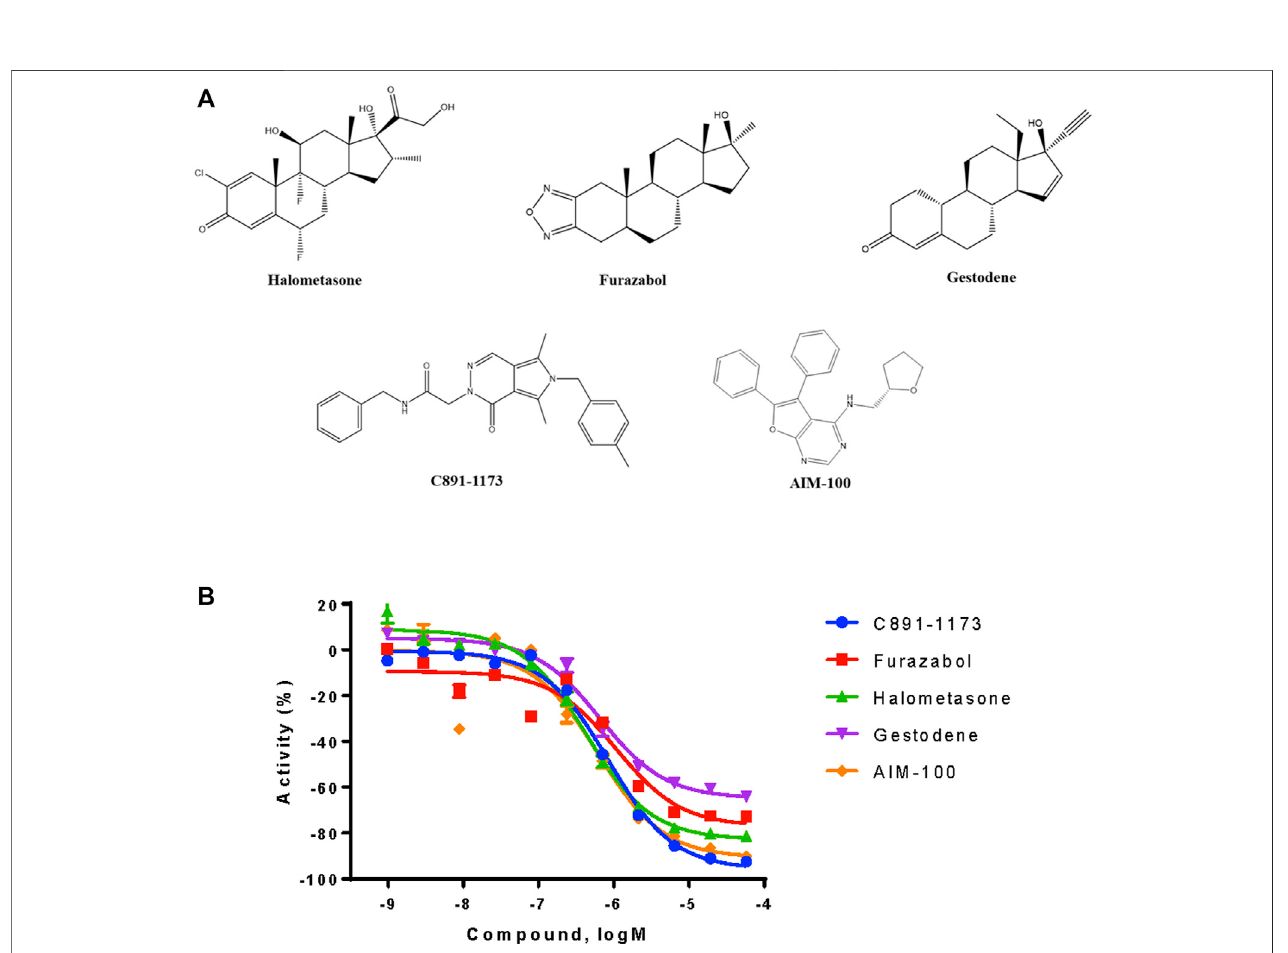
FIGURE 4 | Structures and inhibition pro fi le of CYP3A7 inhibitors based on P450-Glo CYP3A7 assay with a > 10-fold IC 50 difference against CYP3A4.